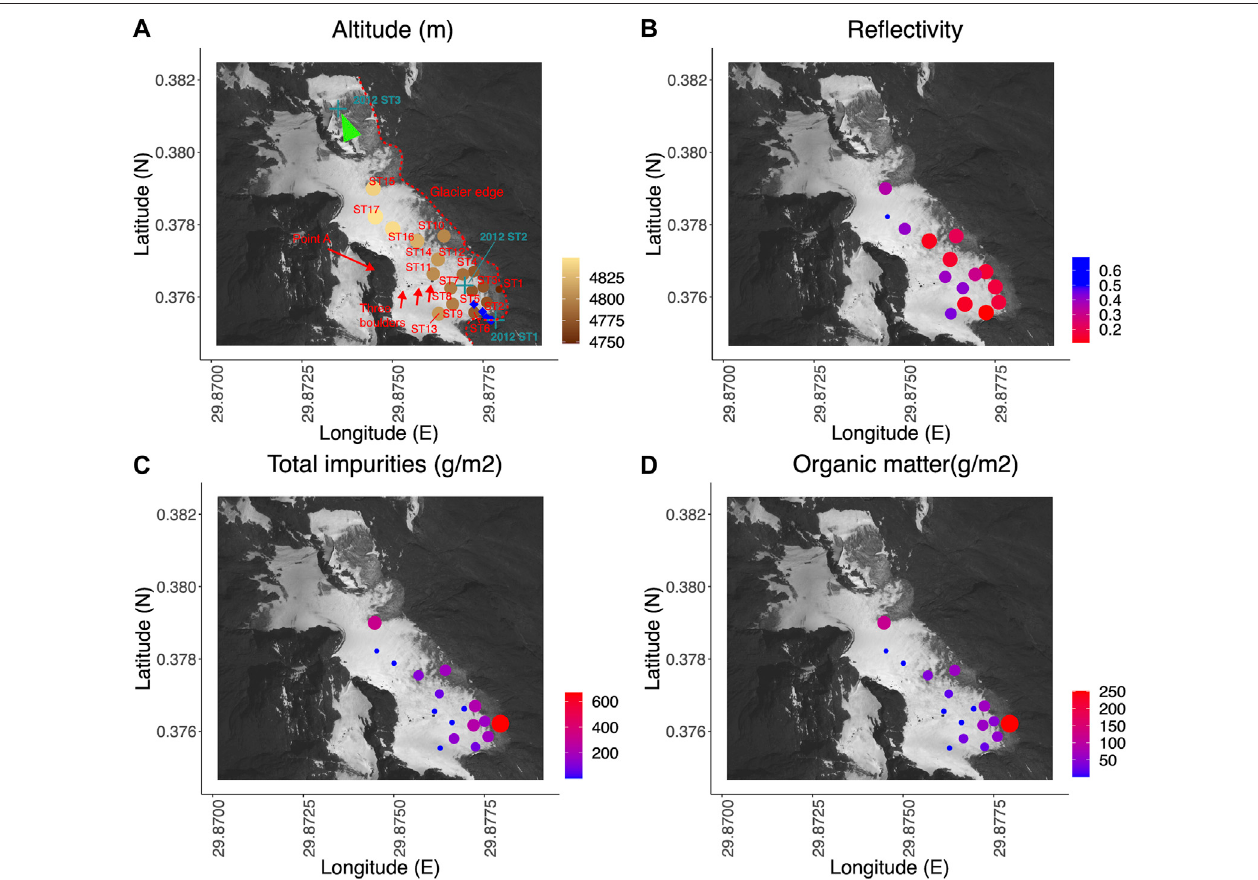
FIGURE3| Satelliteimage(Worldview)ofsamplingsitesonStanleyGlacierin22January2012andspatialdistributionofre fl ectivityandtotalimpuritiesandorganic matters. An overview picture of the corresponding sampling area is given in Figure 3 . (A) Altitude of sampling sites in 2015 (circles), and site locations of snow depth measurementsin2013(bluediamonds)andofphototrophcollectionin2012(tealgreencross).Thereddashedlineindicatesglacierterminusandmarginson22January 2012; (B) re fl ectivity (spectral range: 353 – 1,008 nm); (C) total impurity content; (D) organic matter content. Point values (circles) are displayed through their respective color and size. Green triangle shows the position and angle of view used in Figure 2 .